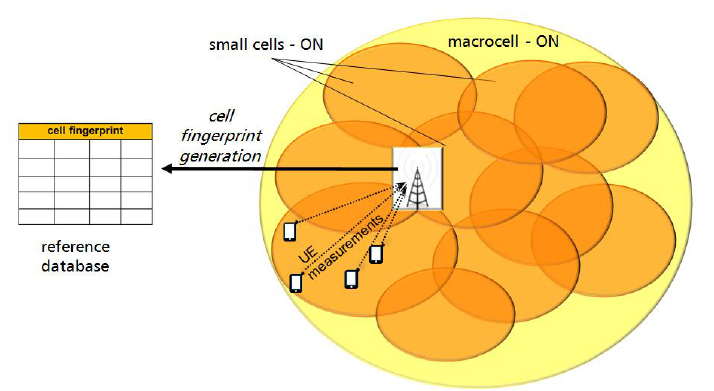
Figure 1. Learning phase - cell fingerprint generation